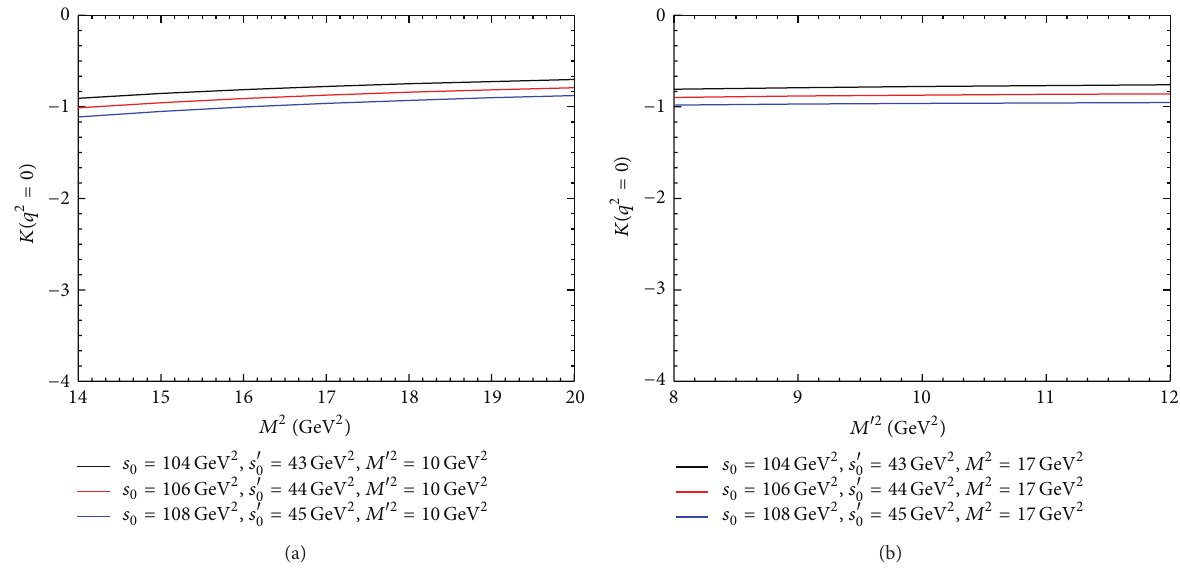
Figure 1: (a) 𝐾(𝑞 2 = 0) as a function of the Borel mass parameter 𝑀 2 at fixed values of 𝑠 0 , 𝑠 󸀠 0 , and 𝑀 󸀠2 . (b) 𝐾(𝑞 2 = 0) as a function of the Borel mass parameter 𝑀 󸀠2 at fixed values of 𝑠 0 , 𝑠 󸀠 0 , and 𝑀 2 .